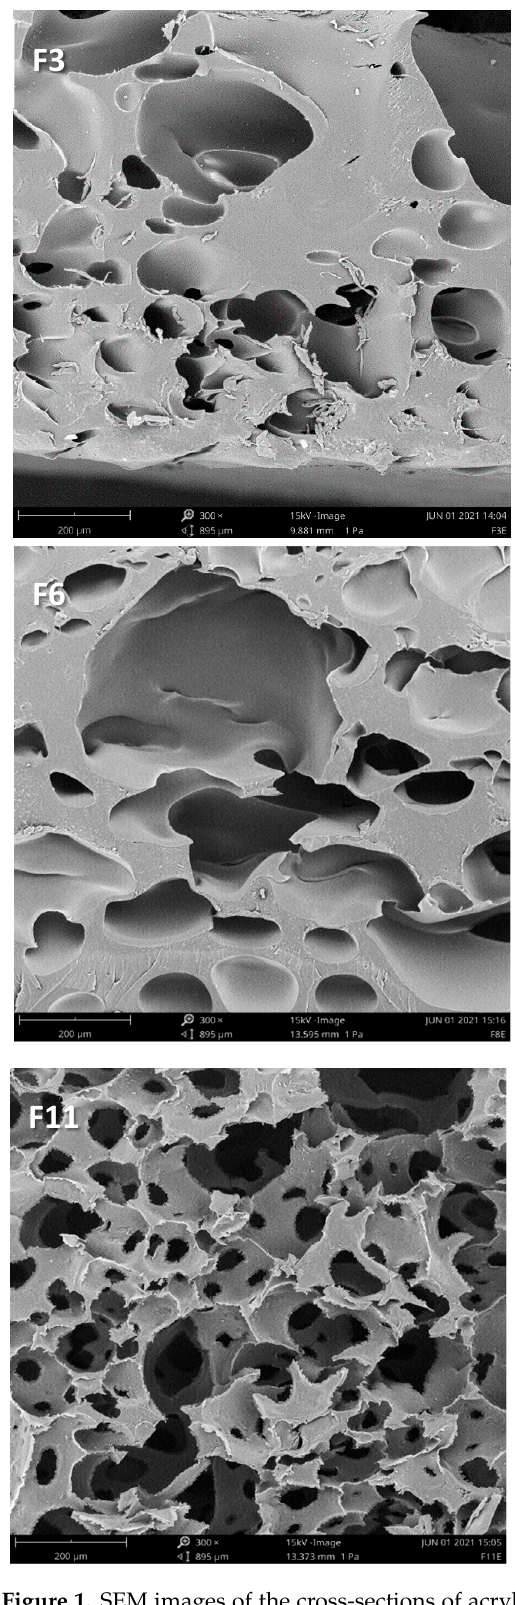
Figure 1. SEM images of the cross-sections of acrylic coatings F3, F6, and F11. The coatings were fractured under liquid nitrogen. Magnification: 300×.